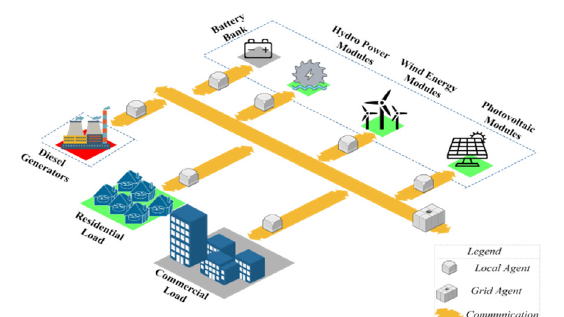
Fig. 1: Block Diagram of a typical microgrid